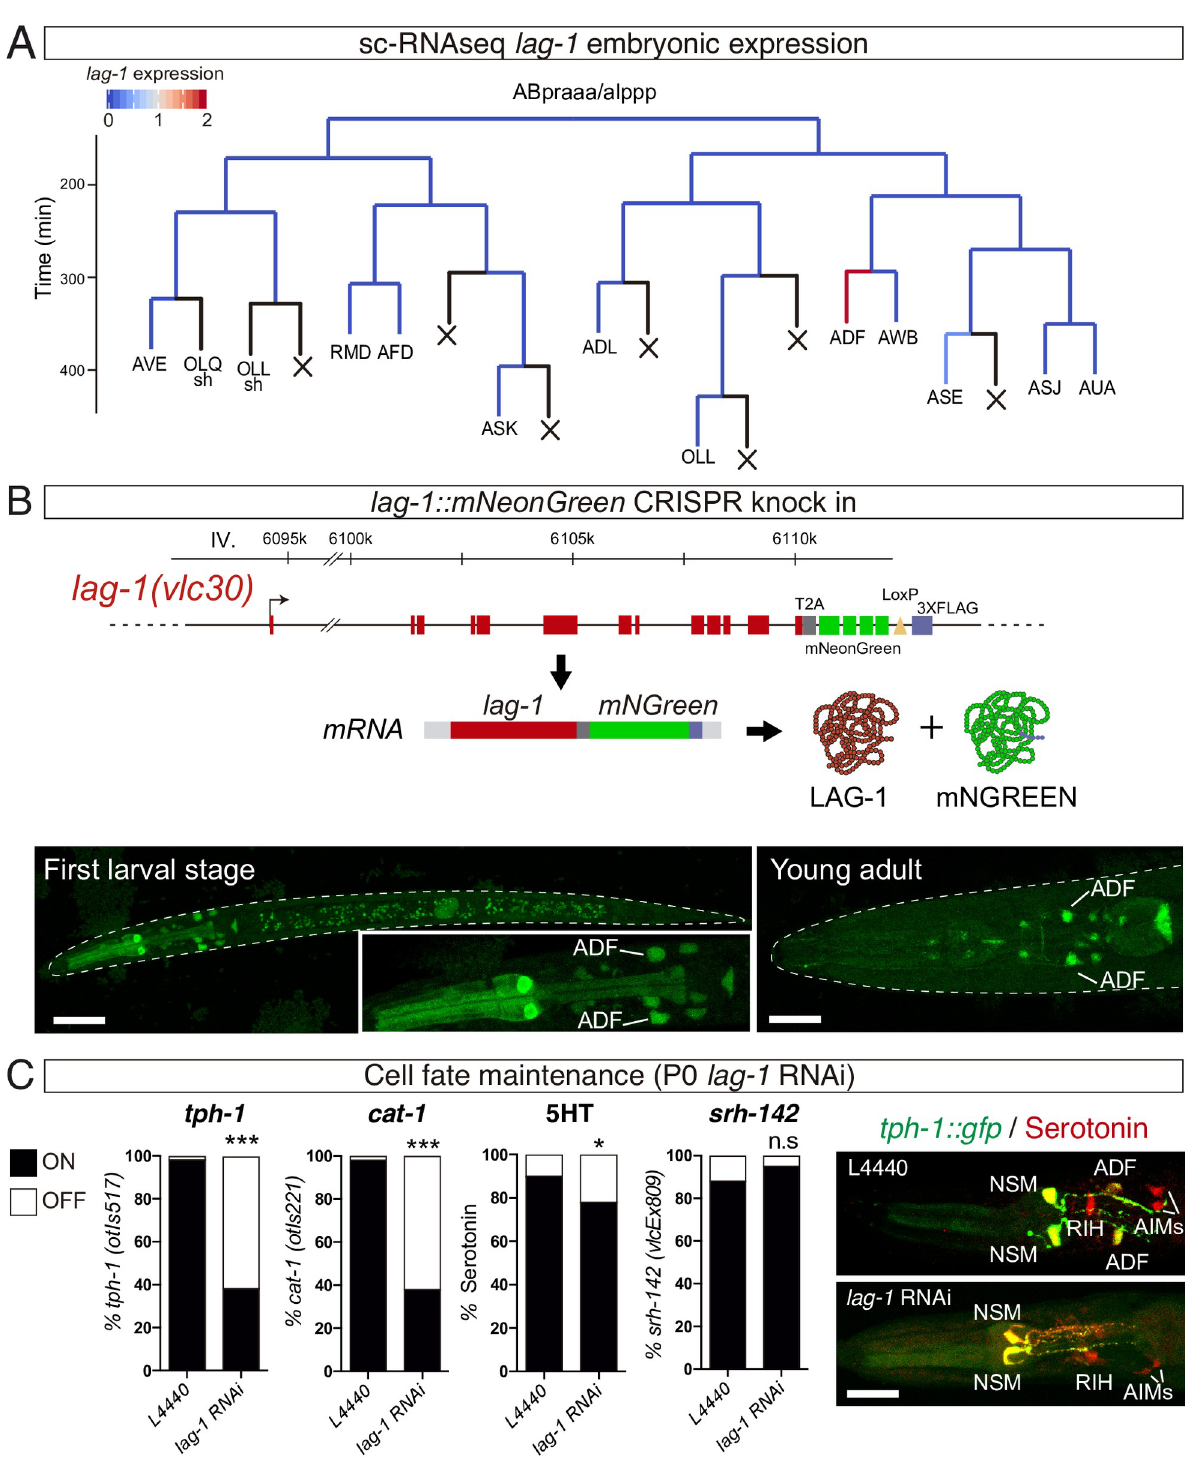
Fig 3. LAG-1 is expressed in postmitotic ADF to induce and maintain ADF neuron fate. (A) ADF lineage representing embryonic lag-1 expression assessed by sc-RNAseq [16]. Black lines represent no expression data available in most cases corresponding to cells that undergo programmed cell death. (B) lag-1 locus tagged with mNeonGreen to monitor lag-1 expression in vivo. Red boxes represent coding exons of lag-1 , grey box T2A sequence, green boxes mNeongreen fluorochrome, yellow triangle LoxP site, and blue box 3x flag tag. This locus gives rise to a single mRNA that undergoes autocatalytic cleavage upon translation. mNeongreen expression in the ADF is observed at L1, and expression is maintained